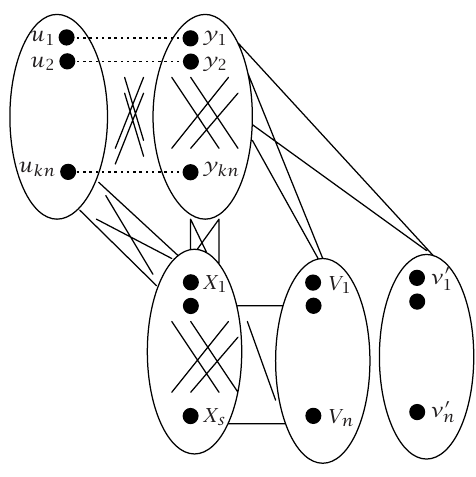
Figure 7.1 . The sketch of the graph G